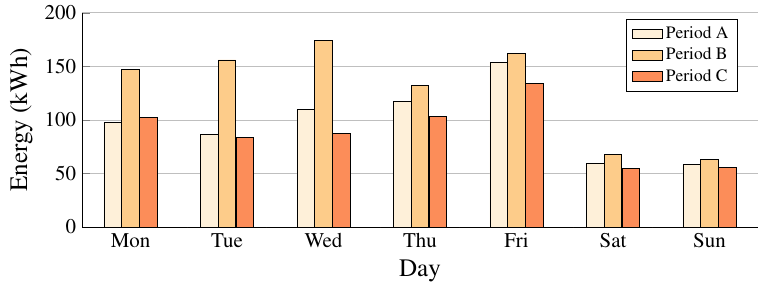
Figure 12. Weekly consumption of PVTL for three periods of the